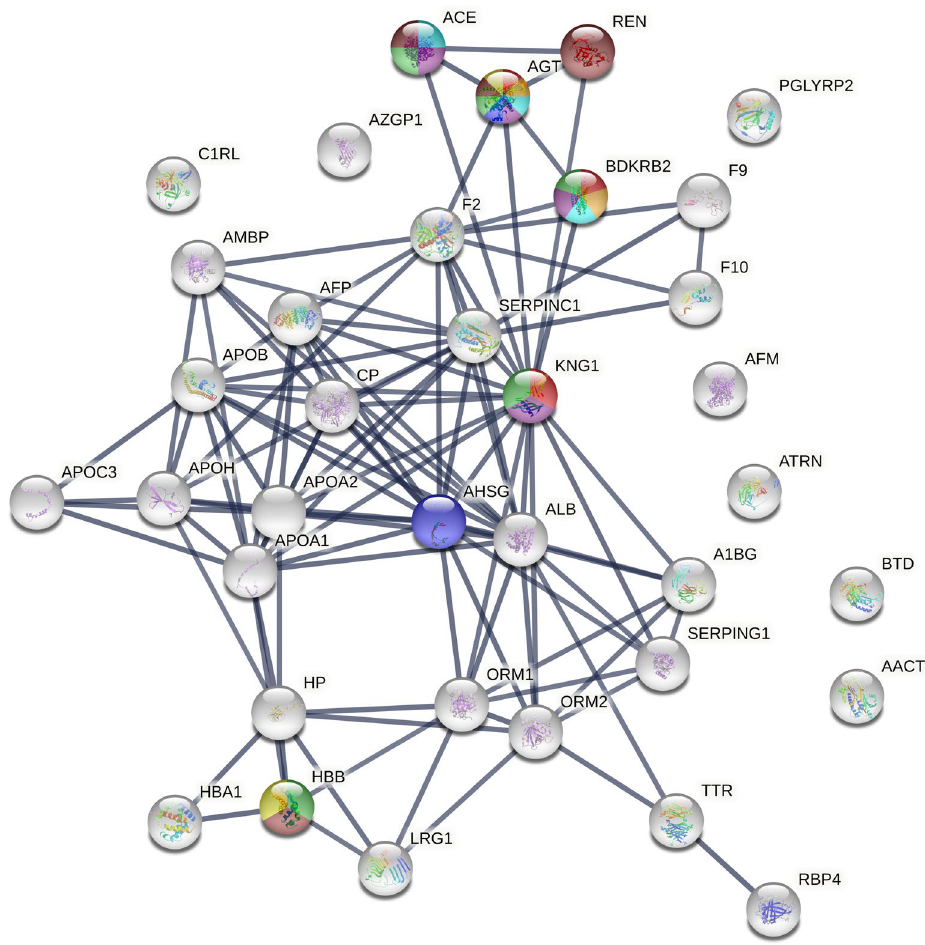
Figure 6. Extended pathway analysis of proteins associated with vascular actions of the proteins most important for the separation before (baseline) and after glucose provocation using the STRING database. Vascular pathways highlighted: red = vasodilation, blue = regulation of cellular response to insulin stimulus, green = regulation of blood vessel diameter, yellow = positive regulation of nitric oxide biosynthetic process, turquoise = regulation of vasoconstriction, orange = vasoconstriction, purple = regulation of tube diameter, brown = regulation of blood pressure. PPI enrichment was < 1.0E −16 . Proteins involved in vascular pathways: AGT = Angiotensinogen, KNG = Kininogen-1, AHSG = Alpha-2-HS-glycoprotein, HBB = Hemoglobin subunit beta, ACE = Angiotensin converting enzyme, REN = Renin, BDKRB2 = B2 bradykinin